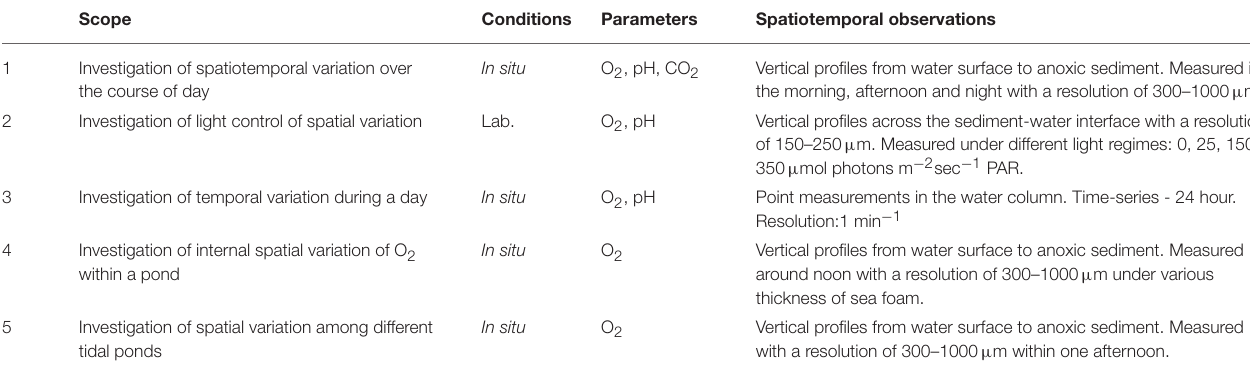
TABLE 1 | Overview of in situ and laboratory investigations conducted to determine the spatiotemporal variation of O 2 , pH, and CO 2 in shallow salt marsh tidal ponds and the role of light as a controlling factor. Scope Conditions Parameters Spatiotemporal observations In 1 Investigation of spatiotemporal variation over the course of day